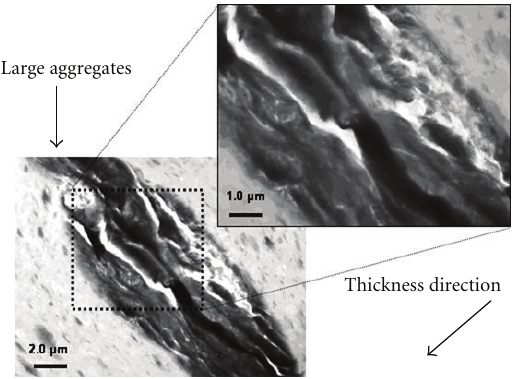
Figure 5: TEM image of nylon-6 film with 10 wt%